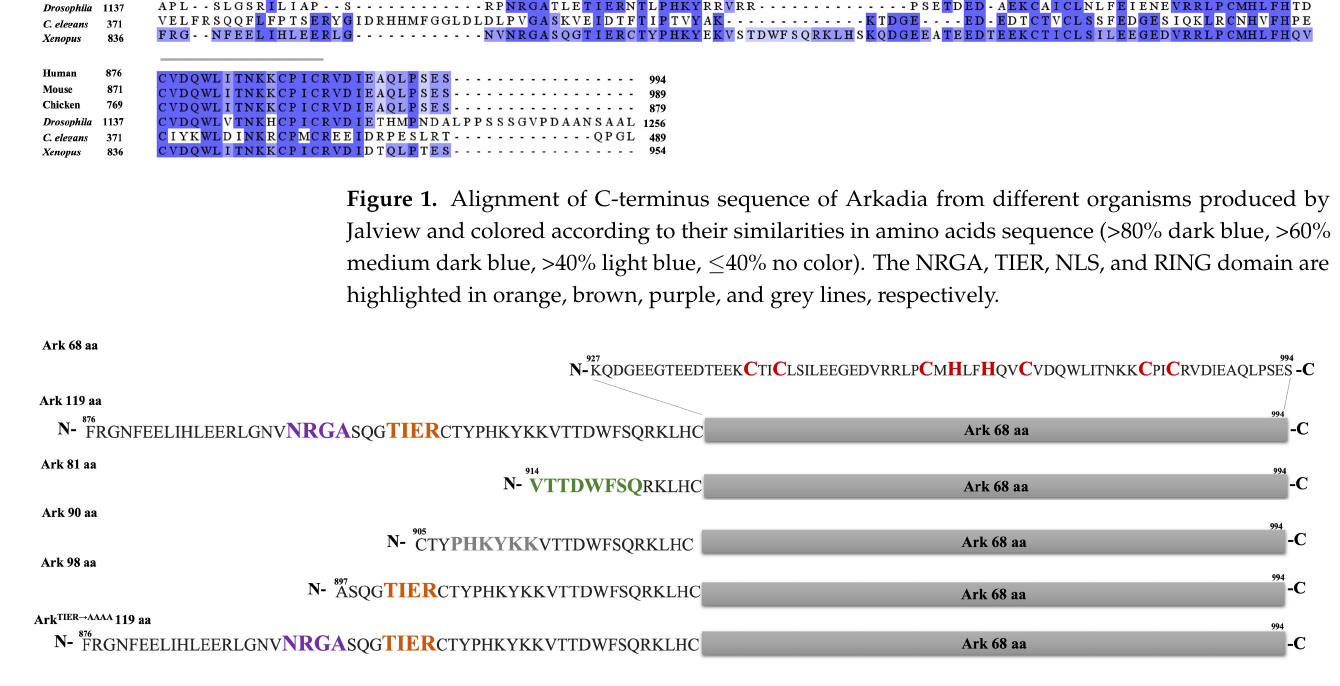
Figure 2. C ‐ terminal constructs of Arkadia E3 ligase. Zinc binding amino acids are colored red, NRGA segment is colored magenta, TIER segment is colored orange, unique for isoform 1 sequence (Val914 ‐ Q921) is colored green, and the NLS is colored grey.